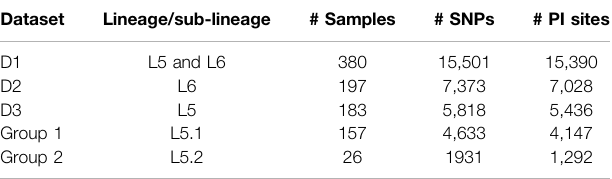
TABLE 1 | Details of datasets and their corresponding total number of SNPs and PI sites used for the study.